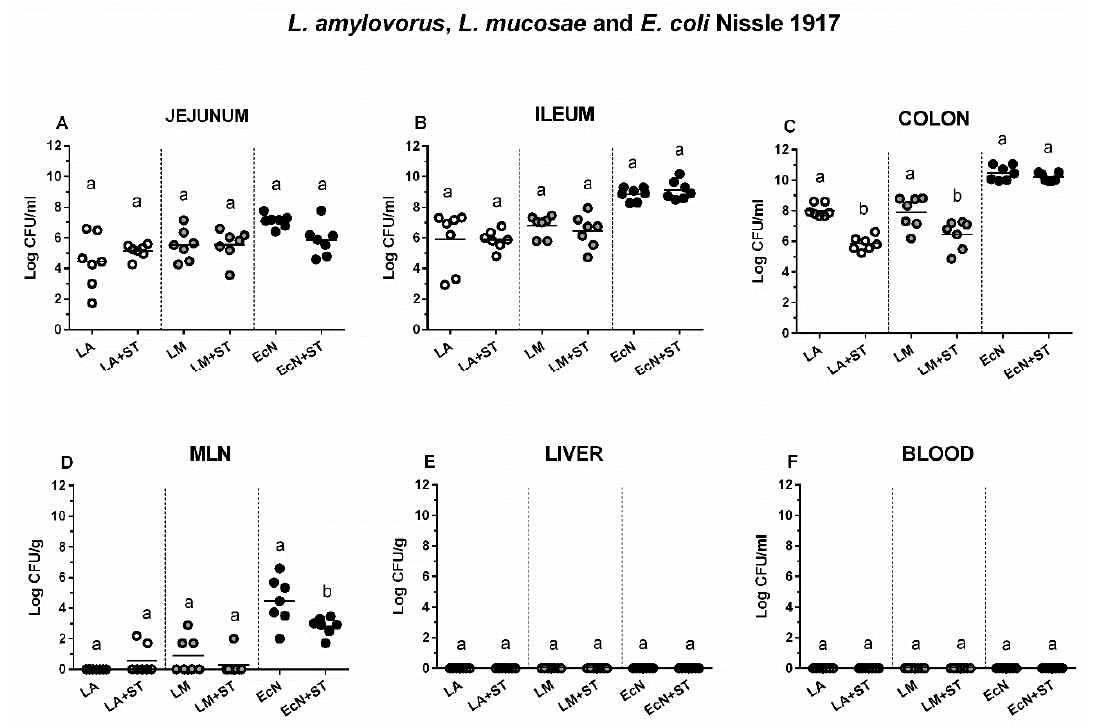
Figure 2. Colonization and translocation of L. amylovorus , L. mucosae , and E. coli Nissle 1917 in the gnotobiotic piglets. L. amylovorus (LA), L. mucosae (LM), and E. coli Nissle 1917 (EcN) colony forming units (CFU) were counted in the jejunum ( A ), ileum ( B ), colon ( C ), mesenteric lymph nodes (MLN; ( D )) the liver ( E ), and blood ( F ) in monocolonized piglets (LA, LM, and EcN) and monocolonized piglets infected with S . Typhimurium (LA + ST, LM + ST, and EcN + ST). Interferences between LA, LM, EcN, and ST as LA vs. LA + ST, LM vs. LM + ST, and EcN vs. EcN + ST, respectively were evaluated by one-way ANOVA with Sidak’s multiple comparisons post-hoc test. Statistical di ff erences were marked by a letter system at P < 0.05. The same letter means no statistical significance. Log CFU are depicted as individual spots with mean as a horizontal line and n = 7 for all groups.